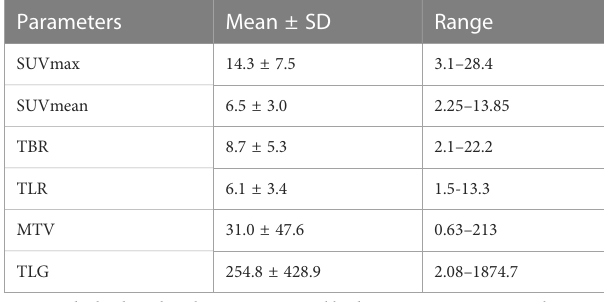
TABLE 2 Summary of investigated metabolic parameters.